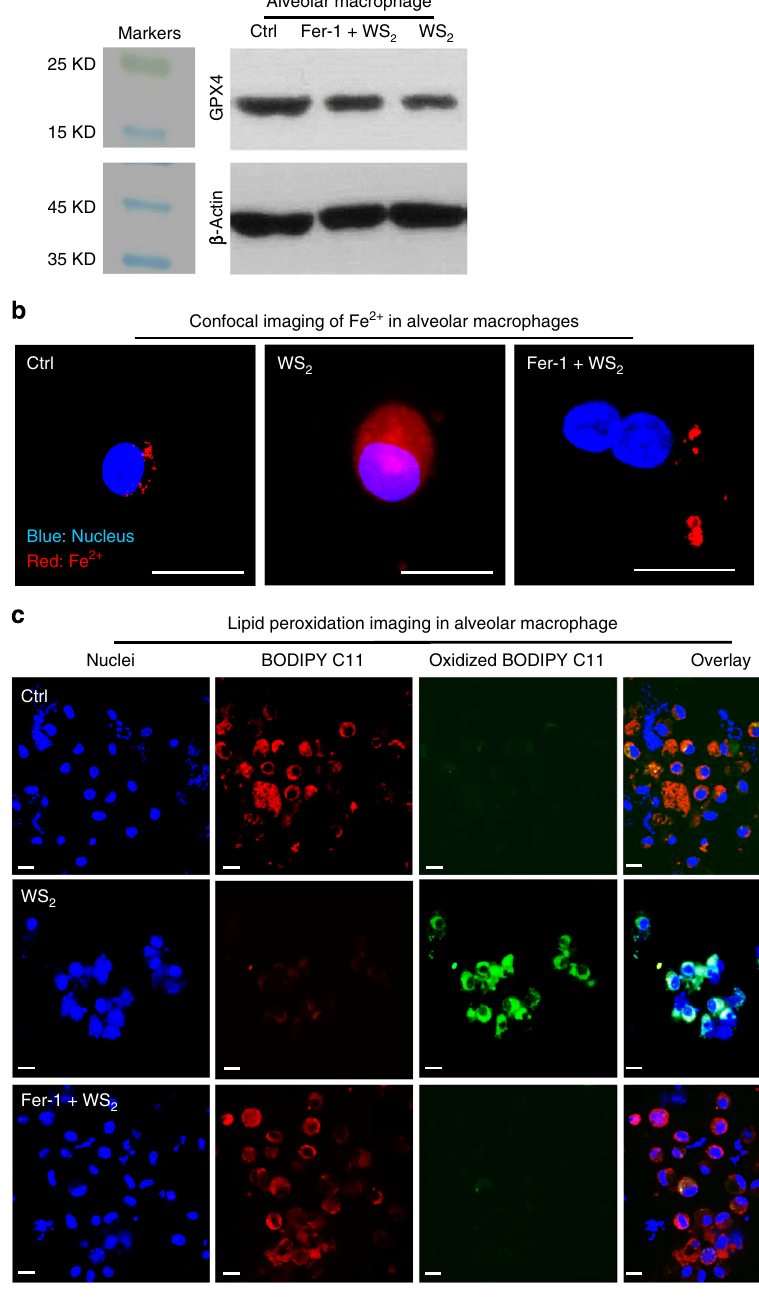
Fig. 6 Validation of ferroptosis in alveolar macrophages from lung tissue. a Representative Western blotting images of GPX4 from three independent experiments, b representative images of lysosomal release of Fe 2 + , and c lipid peroxidation in alveolar macrophages from four independent views. Animals pretreated with or without 50 μ g/Kg Fer-1 for 2 h were exposed to 1 mg/Kg WS 2 for 40 h ( n = 6 mice). Then the BALF of animals were collected to extract alveolar macrophages. The cells were divided into three portions. One was lysed for Western blotting analysis, and the other two were stained by Image-iT lipid peroxidation staining kit (scale bar: 10 μ m) to visualize nuclei (blue), reduced substrate (red) and oxidized substrate (green), or FeRhoNox-1 (scale bar: 10 μ m) to observe lysosomal release of Fe 2 +